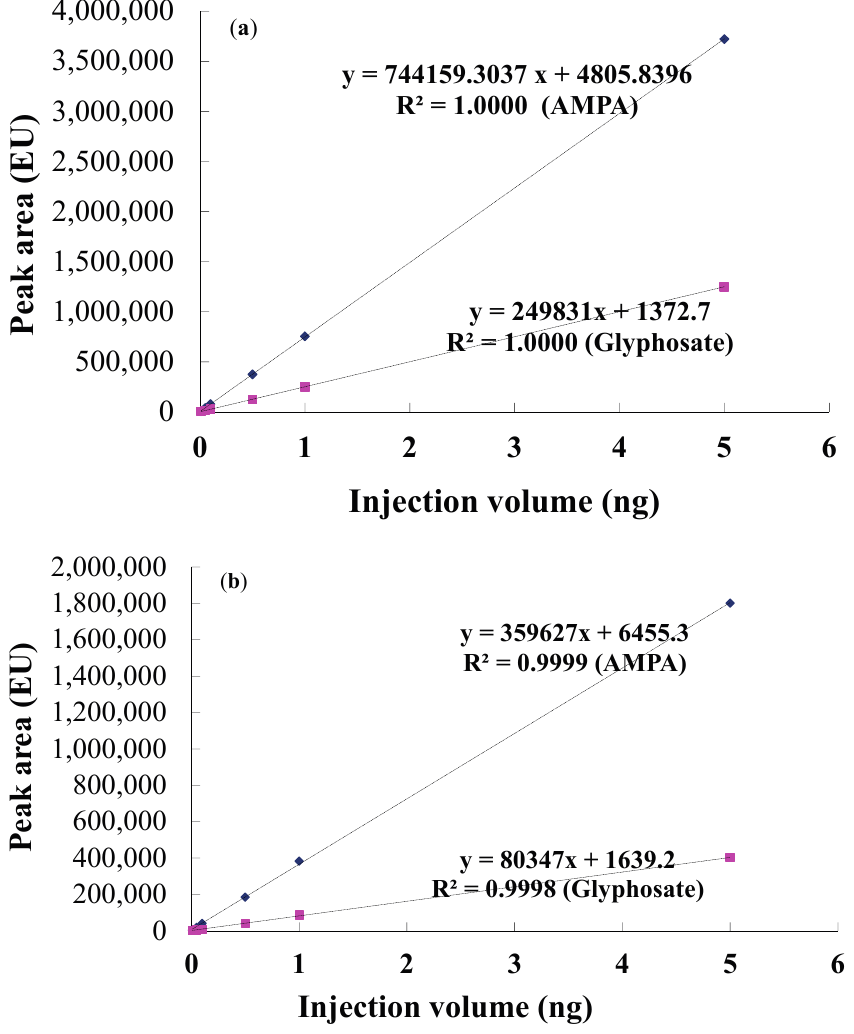
Figure 1. Standard curves of glyphosate and AMPA ( a ) ddH 2 O and ( b ) soil